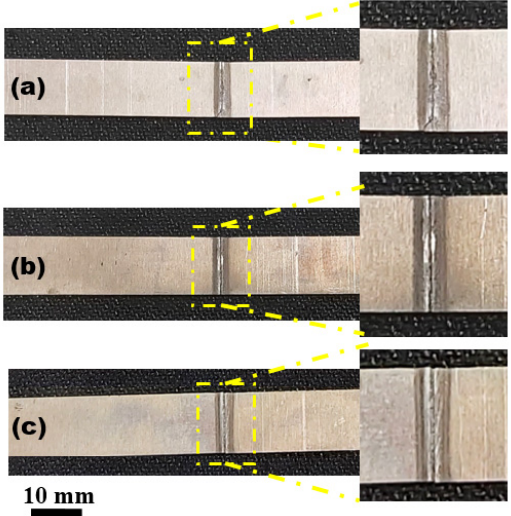
Figure 12. Representative AA7075-T6 welded samples after tensile test: ( a ) standard sample without heat treatment; ( b ) water-quenched; ( c ) air-quenched.